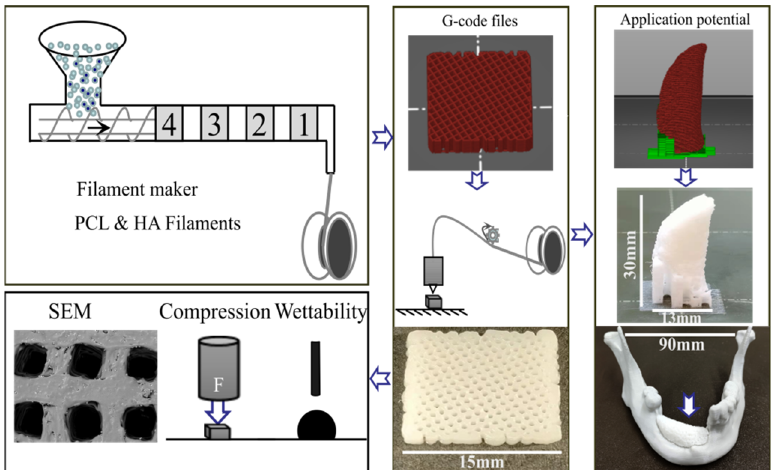
Figure 1. Filament fabrication and material extrusion-based 3D printing. 4, 3, 2, 1: separate zones in the filament-maker. The new composite filament is collected and used for 3D printing following the represented G-code file, giving a product of 15 × 15 × 2 mm 3 . The printed scaffold is tested for SEM (scanning electron microscopy), compression, and wettability properties. The same filament is used for potential application in the bone replacement model.